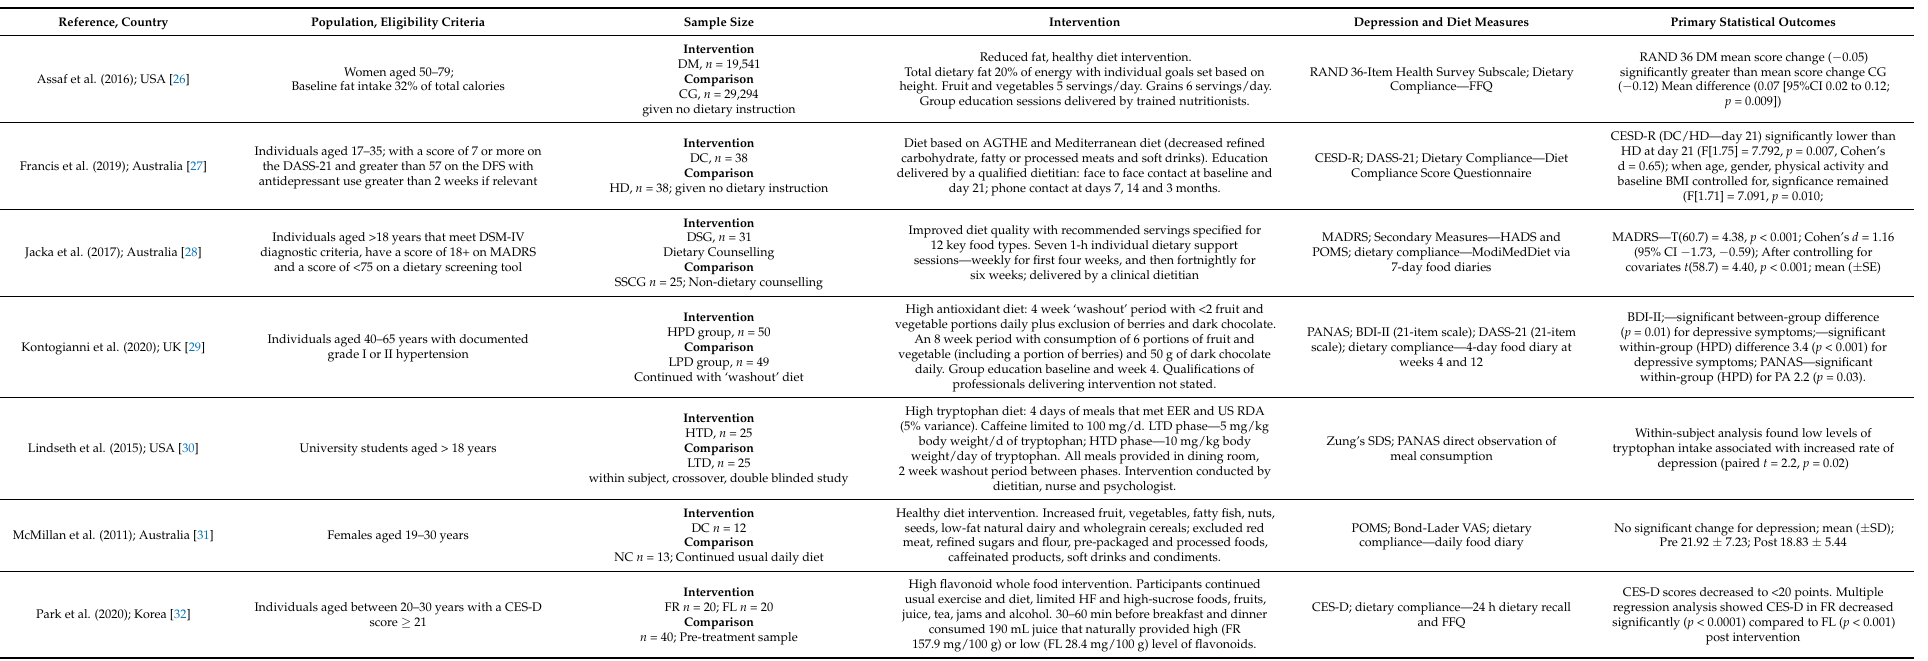
Table 2. Characteristics of Included